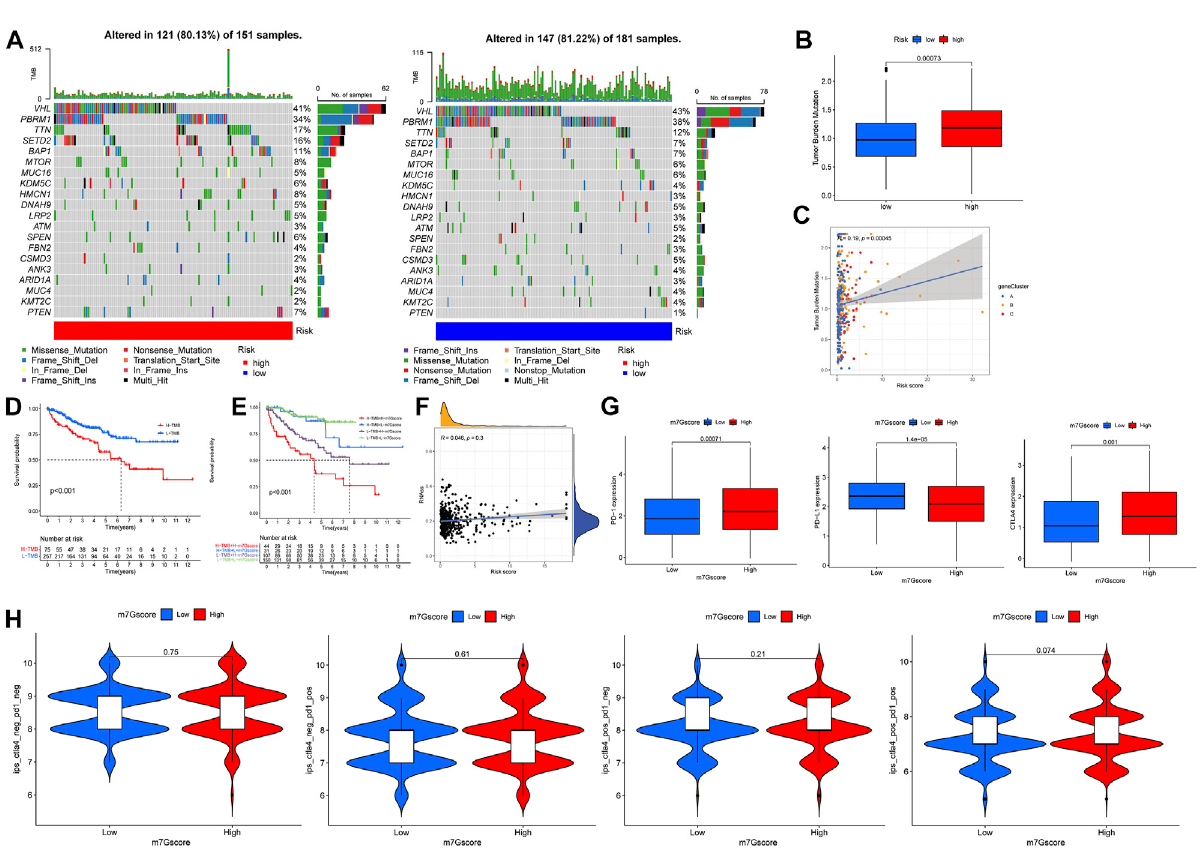
Mutation and immune checkpoint therapy. (A) Somatic mutation features of ccRCC patients in high- and low-risk groups, with colors representing different mutation types. (B,C) Correlations between the m7G score and tumor mutation burden. (D,E) Survival difference of patients withdifferentTMB. (F) Correlationsbetween them7Gscore andRNAs. (G) Expressionlevels ofPD-1,PD-L1 andCTLA4 inhigh- andlow-risk groups. (H) Analysis of the m7G score in anti-PD-L1 and CTLA-4